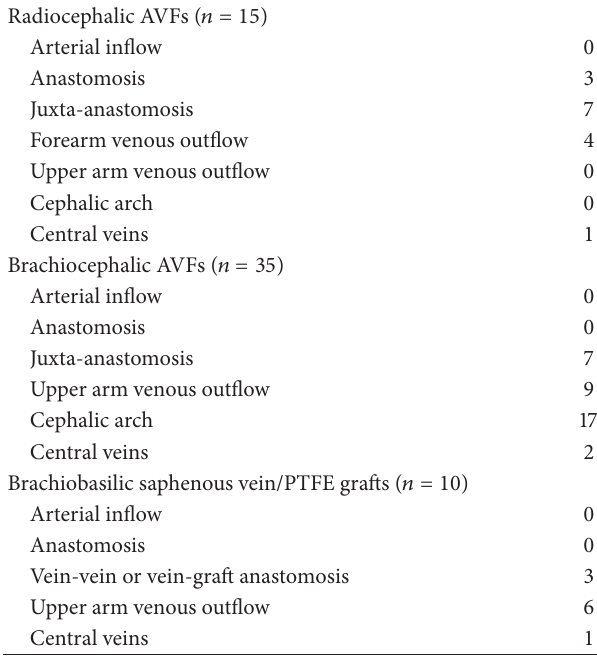
Table 2: Stent location according to access